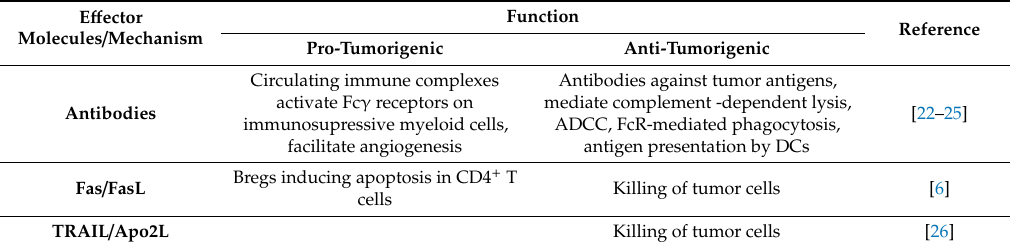
Table 1. Overview of the molecules produced by B cells in the context of cancer and their e ff ect on tumor